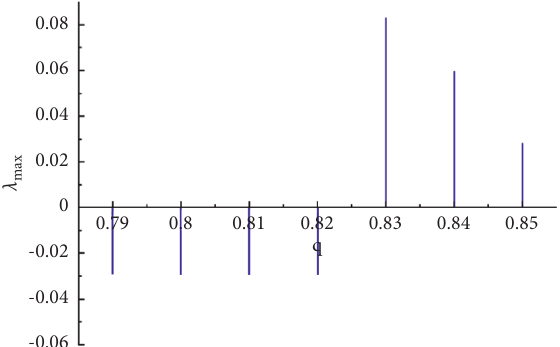
Figure 2: The largest Lyapunov exponent with the variation of derivation order